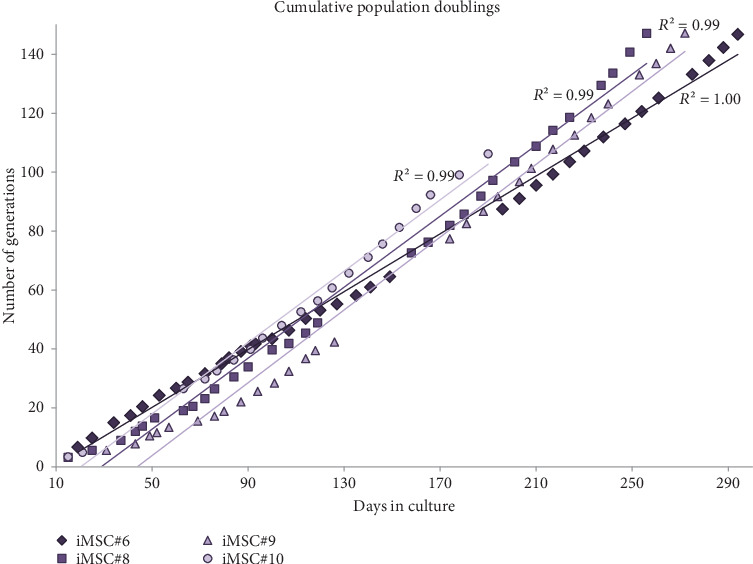
Number of generations accumulated by iMSC#6, iMSC#8, iMSC#9, and iMSC#10, calculated as (logNf–logNi)/log2 (where Nf is the final cell population, Ni is the number of cells in the inoculum, and log is the natural logarithm), facing days in culture. R > 0.99 and p value < 0.00005 for all four iMSC line growth curves.